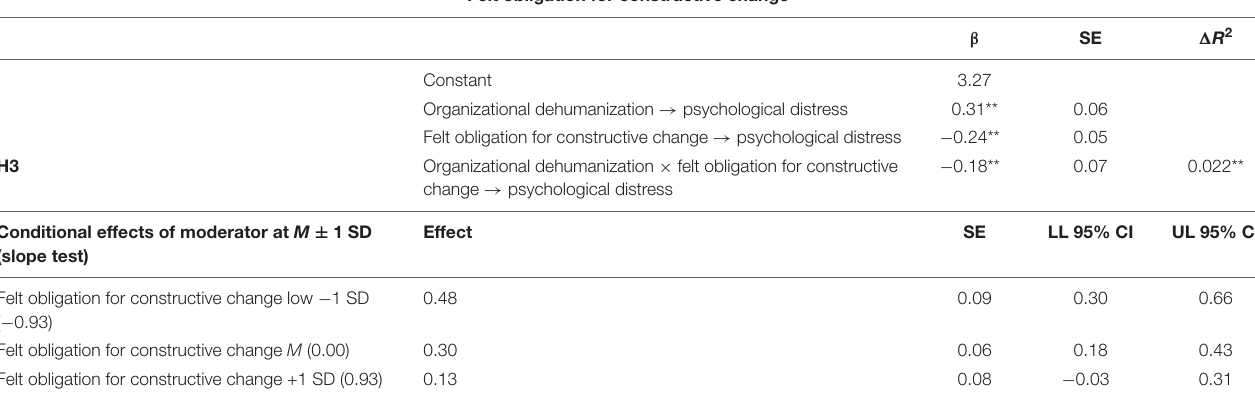
TABLE 4 | Moderation analysis.